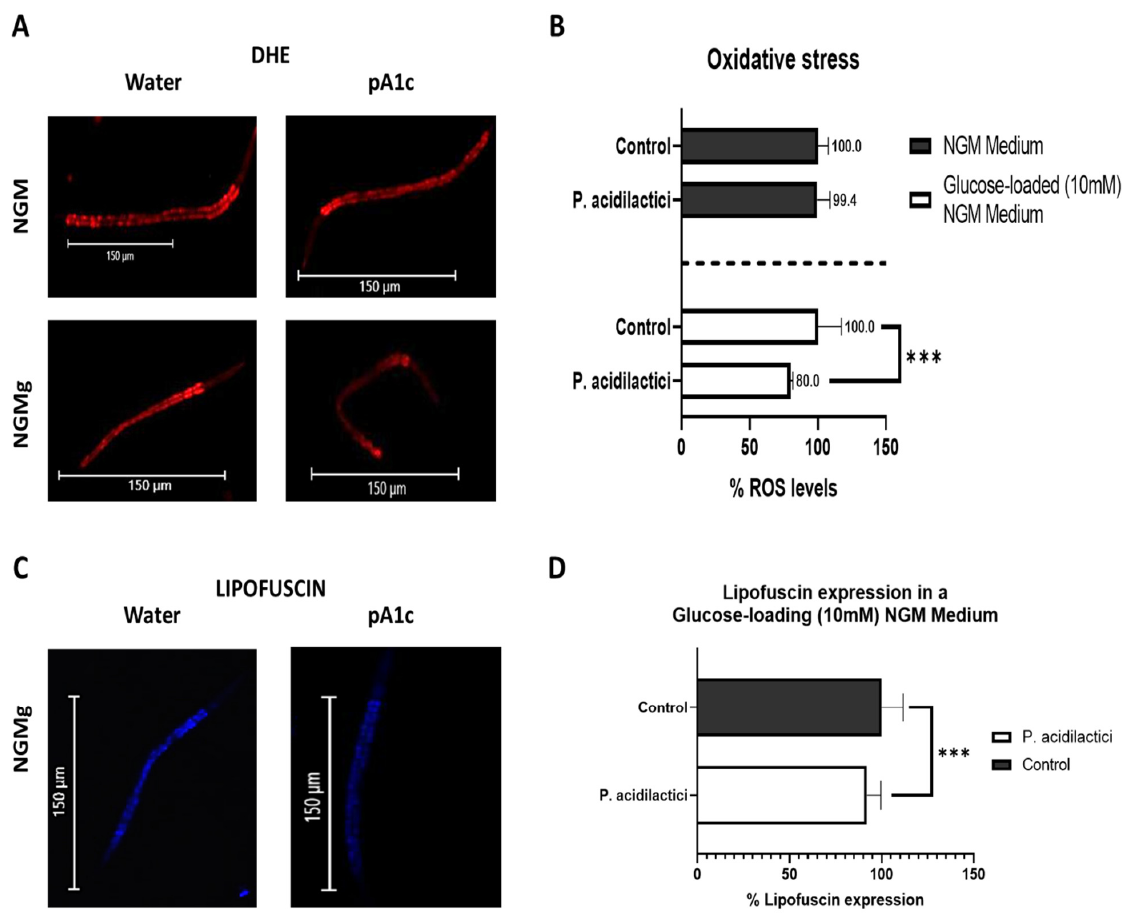
Figure 5. Pediococcus acidilactici improves C. elegans health span ( A ) DHE staining of water-and pA1c-treated worms in a NGM medium and in a glucose-loaded (10mM) NGM medium. ( B ) ROS production quantification (measured by DHE) of water- and pA1c-treated worms (5 × 10 6 CFU) in a NGM medium and in a glucose-loaded (10mM) NGM medium. Results are expressed as the mean ± standard deviation relative to control worms in a NGM medium or in a glucose-loaded (10mM) NGM medium. Significance refers to the effect of pA1c with respect to control worms in a NGM medium or in a glucose-loaded (10mM) NGM medium (Student´s t-Test, *** p < 0.001). ( C ) Lipofuscin aging pigment of water-and pA1c-treated worms in a glucose-loaded (10mM) NGM medium. ( D ) Quantification of lipofuscin aging pigment of water- and pA1c-treated worms (5 × 10 6 CFU) in a glucose-loaded (10mM) NGM medium. Results are expressed as the mean ± standard deviation relative to control worms. Significance refers to the effect of pA1c with respect to control worms in a NGM medium or in a glucose-loaded (10mM) NGM medium (Student´s t-Test, *** p < 0.001).